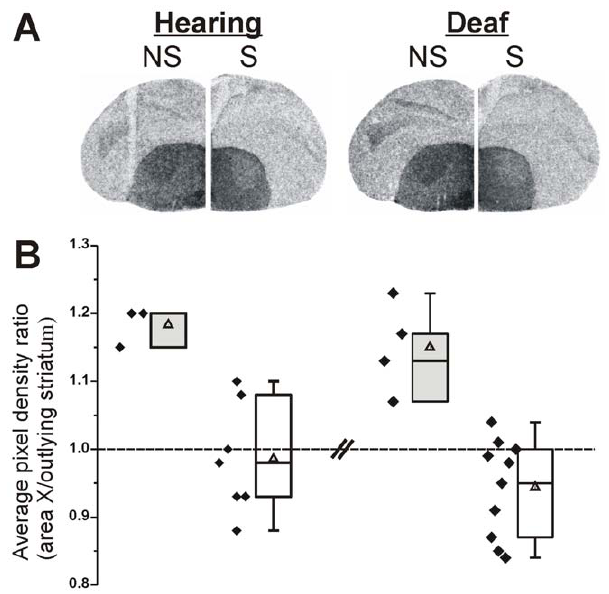
Figure 3. Singing down-regulates FoxP2 in both hearing and deaf juveniles. A ) Representative sections show Fo xP2 signals detected with the 3 9 -probe in hearing and deaf 75d birds. Signals within area X appear slightly stronger than in the surrounding striatum in the non-singer (NS), whereas they appear lower in area X of the singer (S). B ) Quantification of the pixel intensity within area X is normalized to that of the outlying striatum. In both hearing (n=7) and deaf (n=10) birds, area X FoxP2 levels are higher in the non-singing group (gray boxes) relative to the singing group (white boxes). Mean 6 SEM for hearing birds: 75NS-H vs. 75S-H: 1.18 6 0.02 vs. 0.99 6 0.04, Mann-Whitney U =5.7, p , 0.02. Mean 6 SEM for deaf birds: 75NS-D vs. 75S-D: 1.15 6 0.03 vs. 0.94 6 0.02, Mann-Whitney U =8, p , 0.005. ‘Box and whiskers’ plots show the median (line), average (triangle), 25 th and 75 th percentiles (box) and 5 th and 95 th percent confidence intervals (whiskers) for each group. Individual values are plotted to the left.